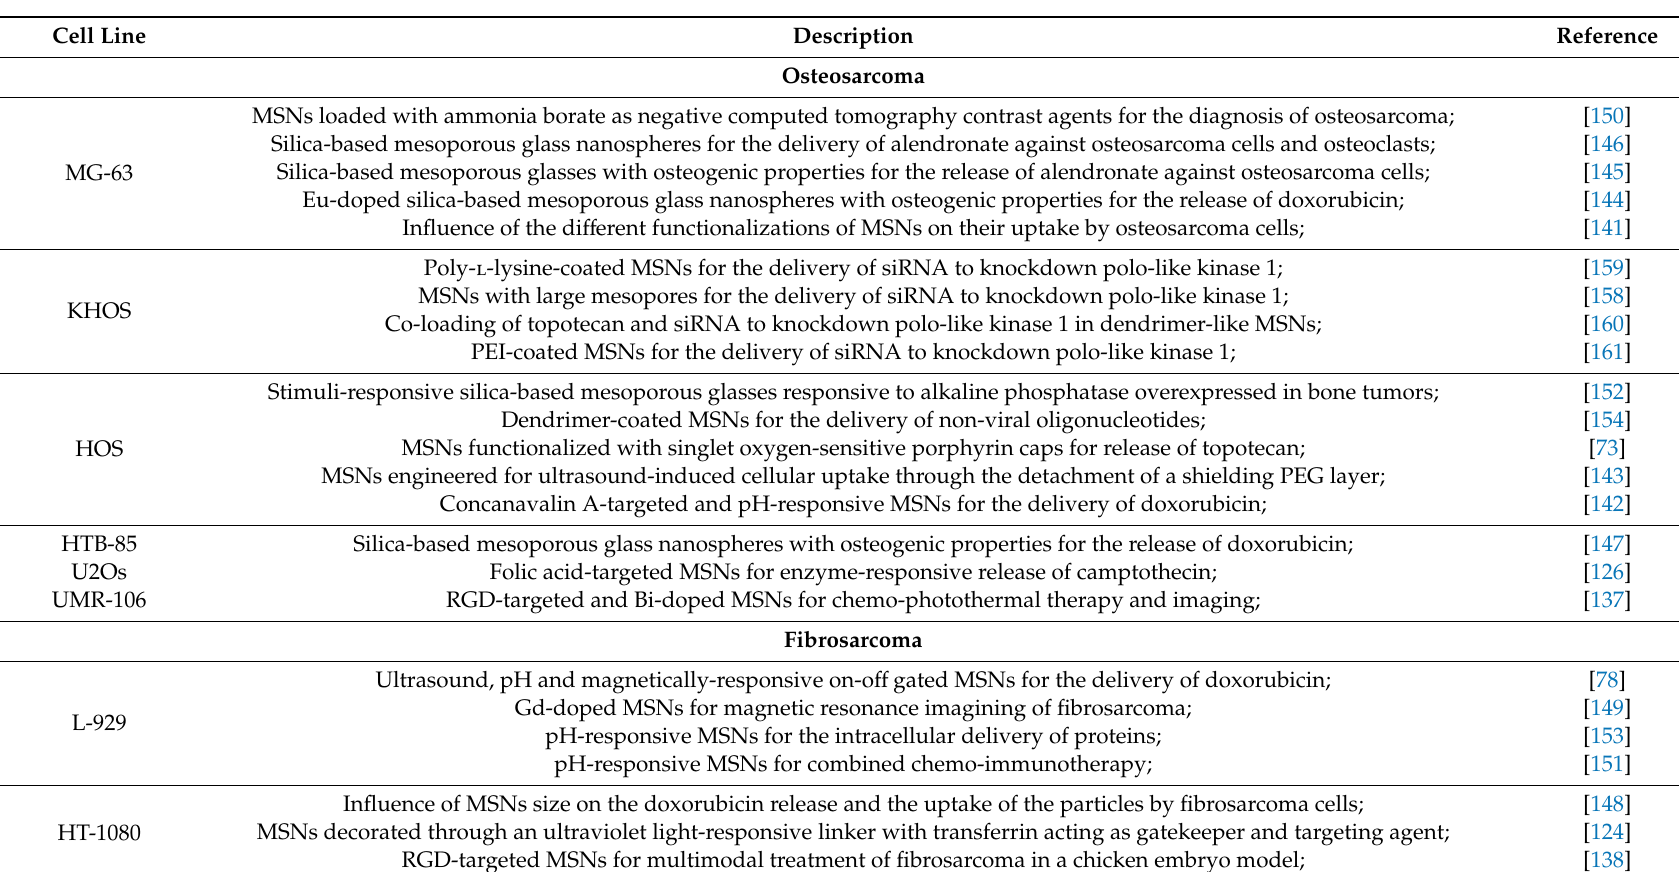
Table 1. Summary of the di ff erent silica-based nanocarriers applied for the treatment of bone